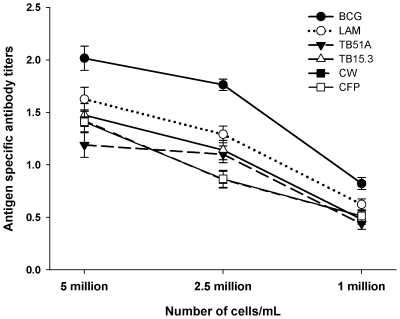
Antigen specific antibody titers against 6 different antigens at various cell concentrations in the micro-ALS assay.Higher concentrations of peripheral blood mononuclear cells produced higher antigen-specific IgG responses. BCG-specific IgG antibody titers were highest followed by LAM-specific IgG antibody levels; antibody responses against CFP, TB51A, TB15.3 and CW were similar.